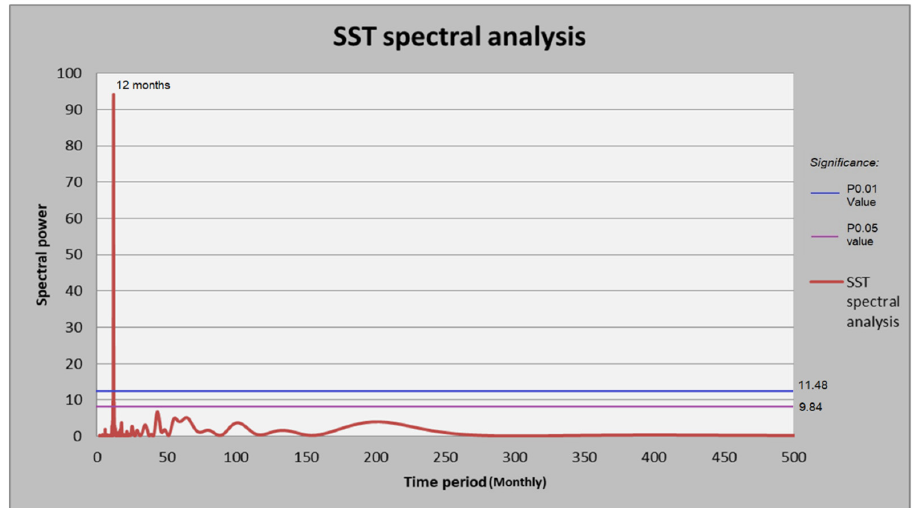
Figure 4. Spectral analysis of the sea surface temperature for the period 1982–2019 on a monthly scale. The red line represents the variability of the spectral power, while the blue line represents the minimum value of significance P0.01 (11.48) and the purple line represents the minimum value of P0.05 (9.84).